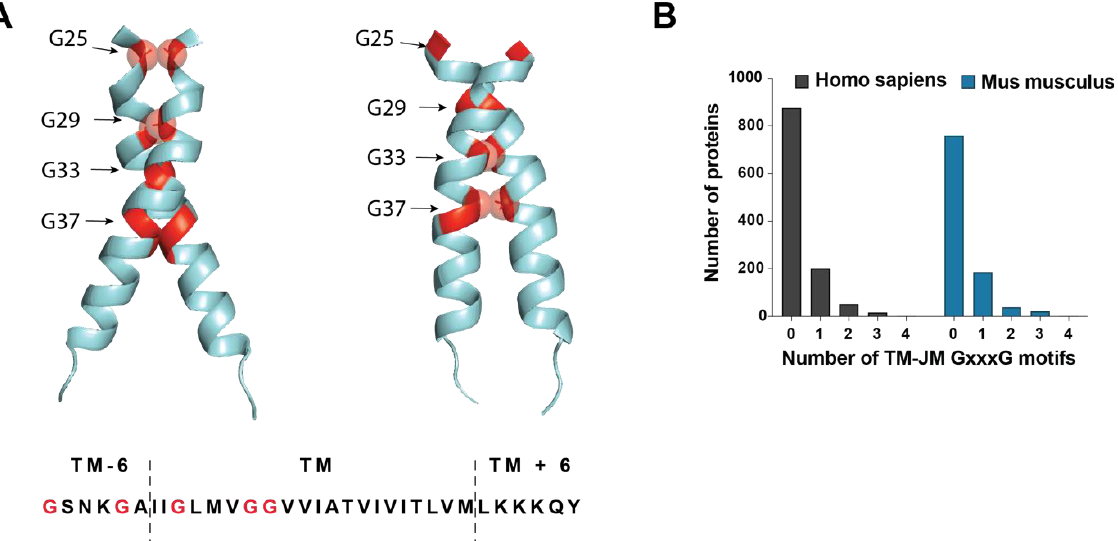
Figure 3. The role of C99 dimerization in Amyloid β generation. ( A ). Illustration of the role of GxxxG motifs in APP C99 dimerization. The figure illustrates the two dimerization interfaces described in [89]. The conformation shown on the left contains the 25 GXXXG 29 motif in the interface and was associated with production of SDS-resistant A β hexameric species. The conformation shown on the right interface contains the 33 GXXXG 37 motif in the interface and was linked to generation of AICD signaling properties and promotion of the A β 42 processing line [89]. Glycines are shown in red, with the one in the interface shown as bubbles. ( B ). Occurrence of GxxxG motif in the TM-JM segments of type I TM proteins in the homo sapiens (black) and mus musculus (blue) proteome. Only one human protein contains 4 GXXXG in the TM-JM segments (not visible in the graph).